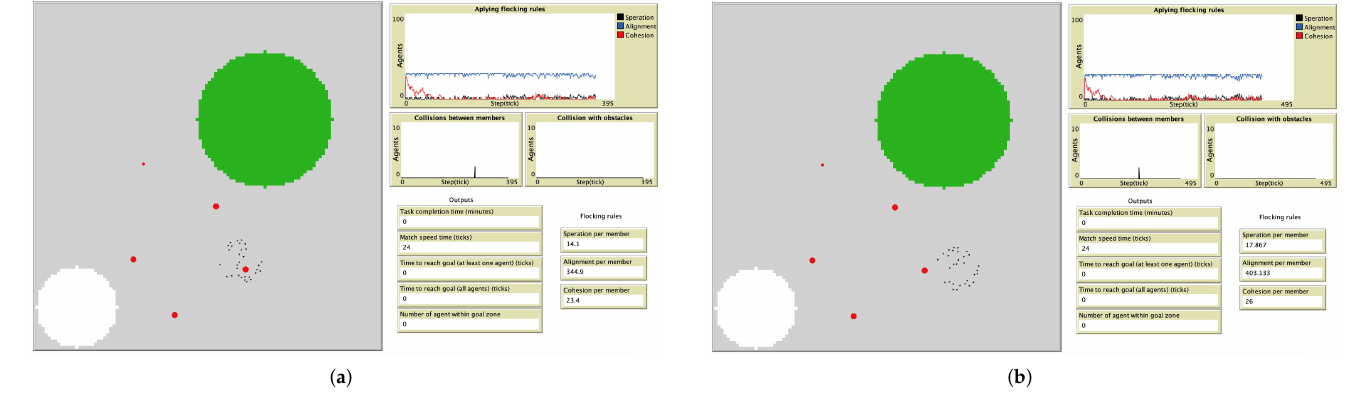
Figure 8. Illustration of flock splitting and rejoining. ( a ) Flock splitting. ( b ) Flock